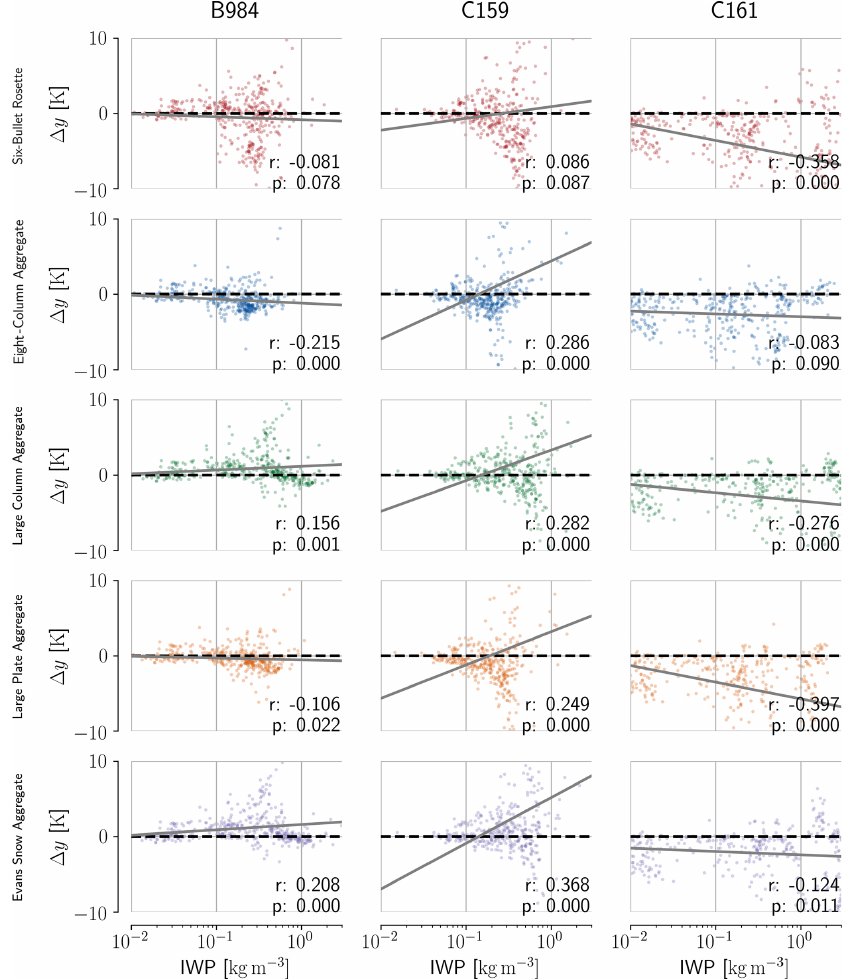
Figure A1. Scatter plots of retrieved IWP and corresponding residual in the fitted observations for the 325 ± 3 . 5GHz ISMAR channel. Each column displays the residual distributions for the five different particle habits. The grey line in each panel represents the regression line for the plotted data points. The text displays the correlation coefficient r and the p value of a two-sided significance test for the slope of regression